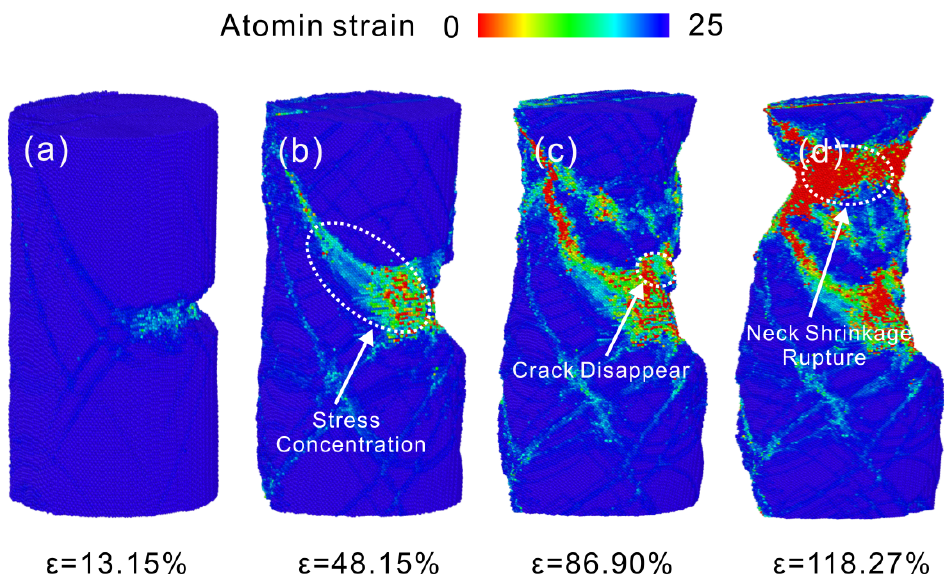
Figure 9. Atomic con fi guration of 25 Å crack depth Cu nanowires at 5 (cid:3400) 10 (cid:2877) s (cid:2879)(cid:2869) strain rate. ( a ) ε = 13.15%, ( b ) ε = 48.15%, ( c ) ε = 86.90%, ( d ) ε = 118.27%. ( a ) ε = 13.15%, ( b ) ε = 48.15%, ( c ) ε = 86.90%, ( d ) ε =